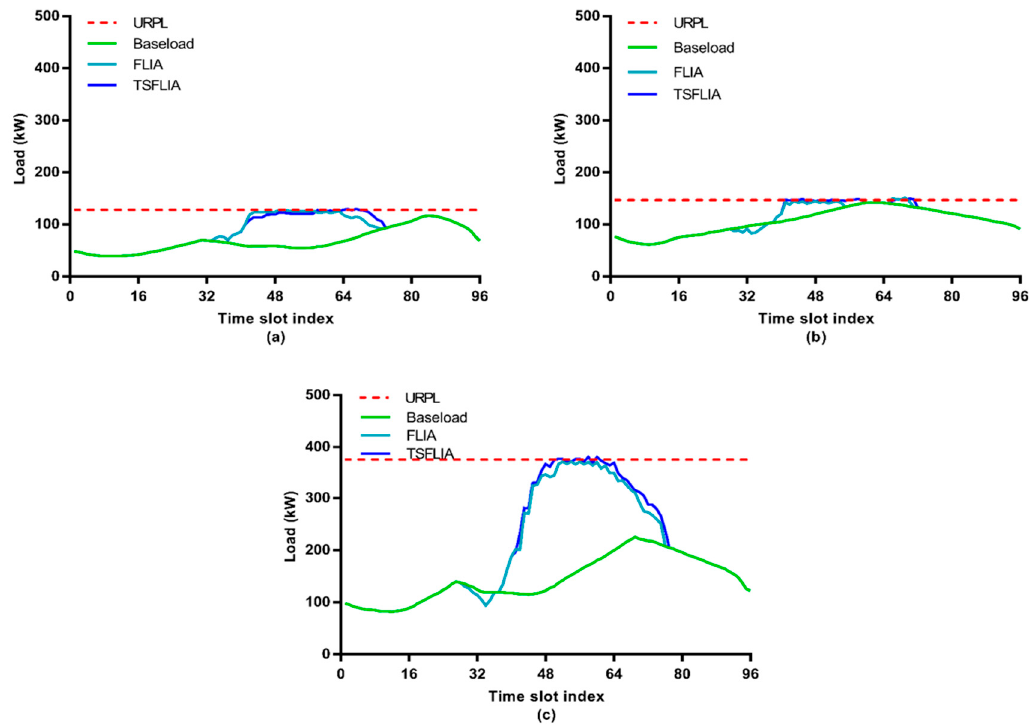
Figure 13. Total load profile of the PLs connected to the three buses: ( a ) Represents the PL connected to the bus #820; ( b ) Represents the PL connected to the bus #834; ( c ) Represents the PL connected to the bus #844.